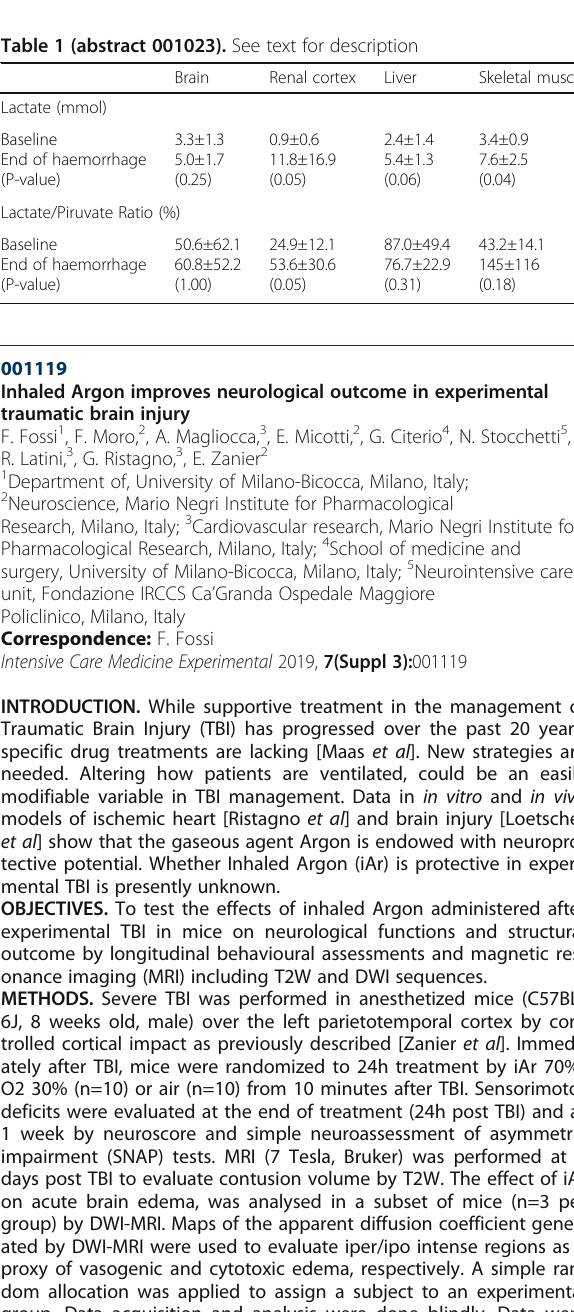
model will be first used to compare the efficacy of different re- suscitation fluids.